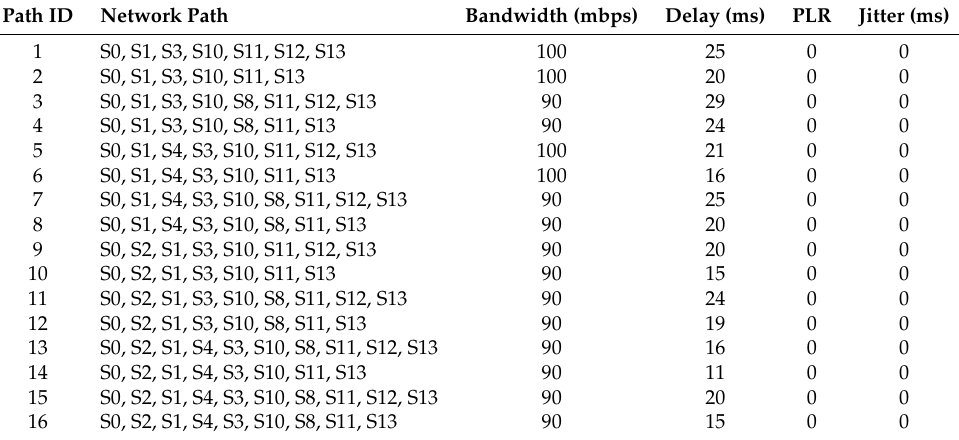
Table 3. Available network paths from Hosts 1 to 6 in the simulation